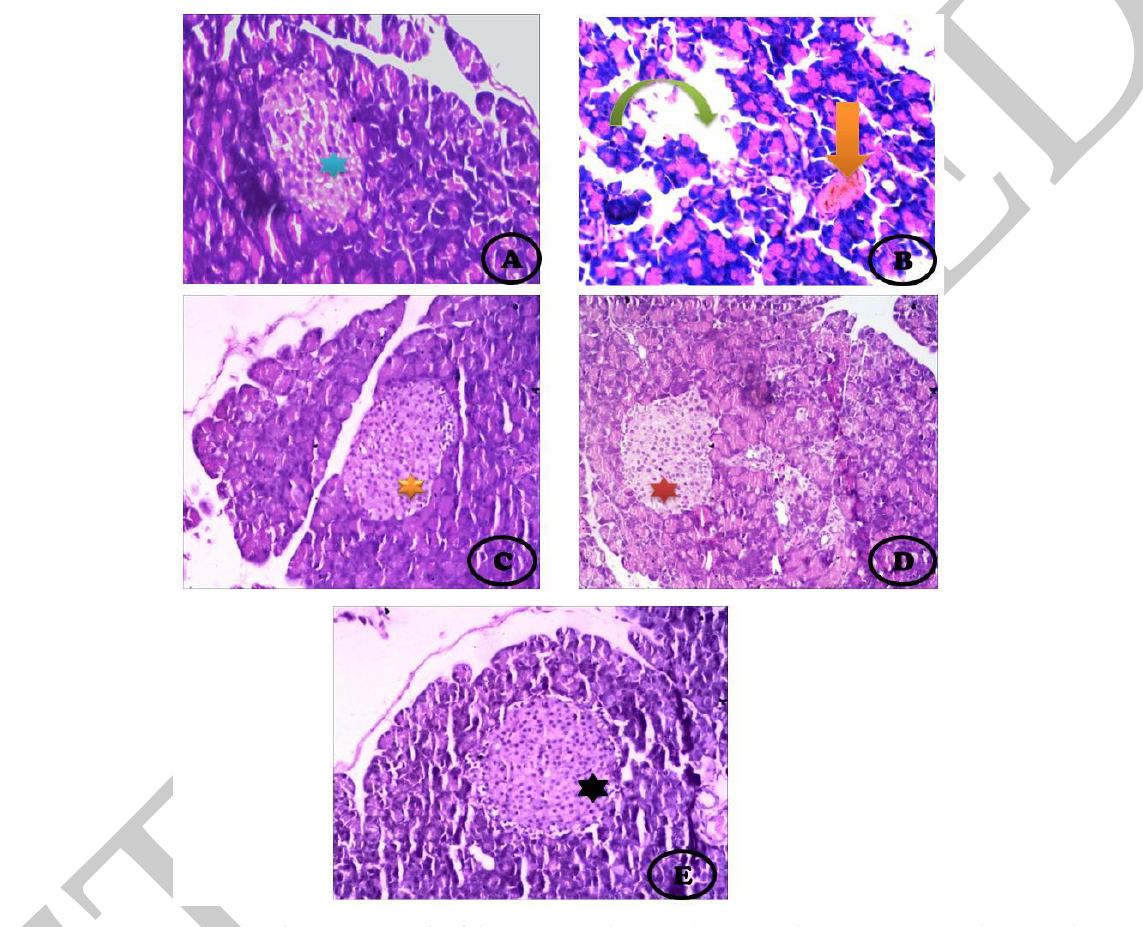
Figure 4. Photomicrograph of the pancreas showing ( A ) Normal pancreatic parenchyma and normal appearance of islets of Langerhans (blue star), acinar cells stain blue at their base due to the presence of a high content of RNA and nuclei, and their apex (lumenal aspect) stains pink where there is a high content of digestive enzymes, ( B ) STZ-treated group showing large detached pancreatic parenchyma (Inverted green arrow) with very reduced and disintegrated islets of Langerhans (orange arrow), ( C ) STZ + stem cell group showing high restoration of detached pancreatic parenchyma with moderate-sized islets of Langerhans (orange star), ( D ) STZ + vit. D showing normal pancreatic parenchyma with moderately irregular islets of Langerhans (red star), ( E ) STZ + stem cells+ vit. D group showing intact pancreatic parenchyma with enlarged islets of Langerhans (black star) compared with the other groups treated separately (H&E, ×400).